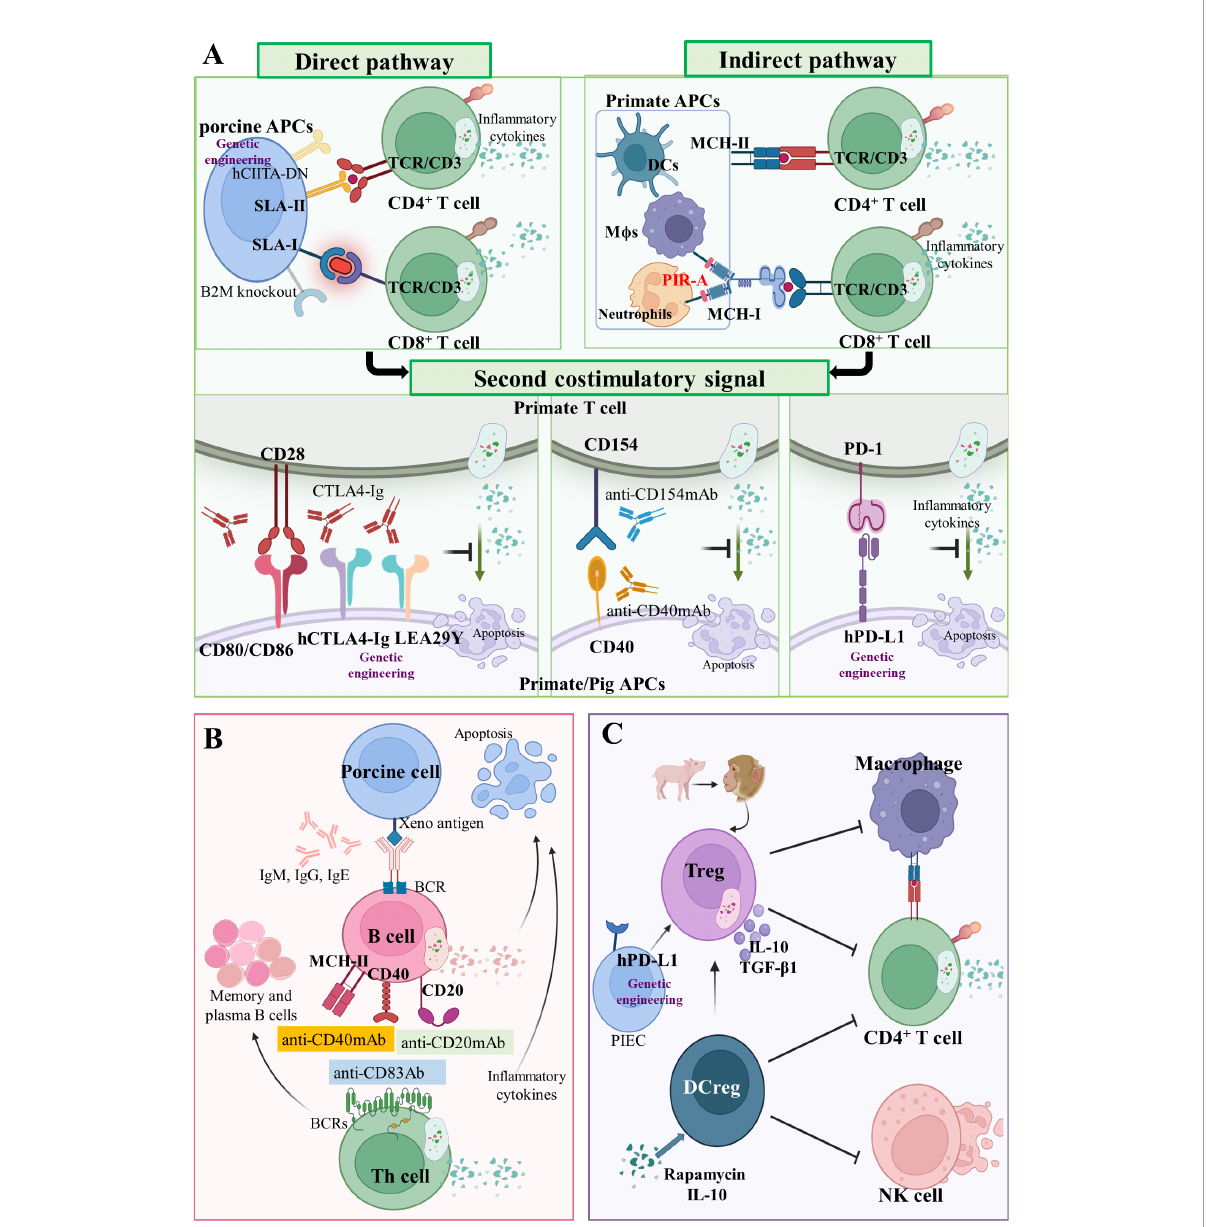
FIGURE 3 Adaptive cellular xenograft rejection (A) T cell response in xenograft rejection. In the direct pathway, T cell receptors (TCRs) of CD4 + and CD8 + T cells in primates interact with SLA-II- and SLA-I-peptide complexes on pig APCs, respectively. Human dominant-negative mutant class II transactivator ( CIITA-DN ) transgene and porcine beta-2-microglobulin knockout ( B2M -/- ) can reduce T cell direct immune response. In the indirect pathway, TCRs of CD4 + and CD8 + T cells in primates interact with MHC-II and MHC-I peptide complexes on primate APCs, respectively. The paired immunoglobulin-like receptor-A (PIR-A) monocytes and macrophages can also directly bind to MHC-I antigens to promote graft rejection. Three important costimulatory signaling axes have been identi fi ed in xenotransplantation, namely CD80/CD86-CD28, CD40-CD154 and PD-1/PD-L1 axis. Drugs targeting these costimulatory signals have been administrated, such as CTLA4-Ig, aCD154mAb, and aCD40mAb. Moreover, the hCTLA4-Ig, LEA29Y, and hPD-L1 transgenes can also inhibit these costimulatory signals. (B) B cells ’ response in xenograft rejection. As antigen-presenting cells, B cells present antigen on MHC-II, CD40, or CD20 the receptor – ligand axis to helper T cells. Some drugs, such as anti-CD83 Ab, anti-CD20 mAb, and anti-CD40 mAb, can control B cells ’ function and in fi ltration of in fl ammatory cells. (C) Regulatory immunological cells response in xenograft rejection. Regulatory T cells (Treg) and regulatory dendritic cells (DCreg) are immunological cells with a negative regulation function. The hPD-L1 transgenic on pig iliac endothelium cells (PIEC) can increase proliferation and suppressive potency of